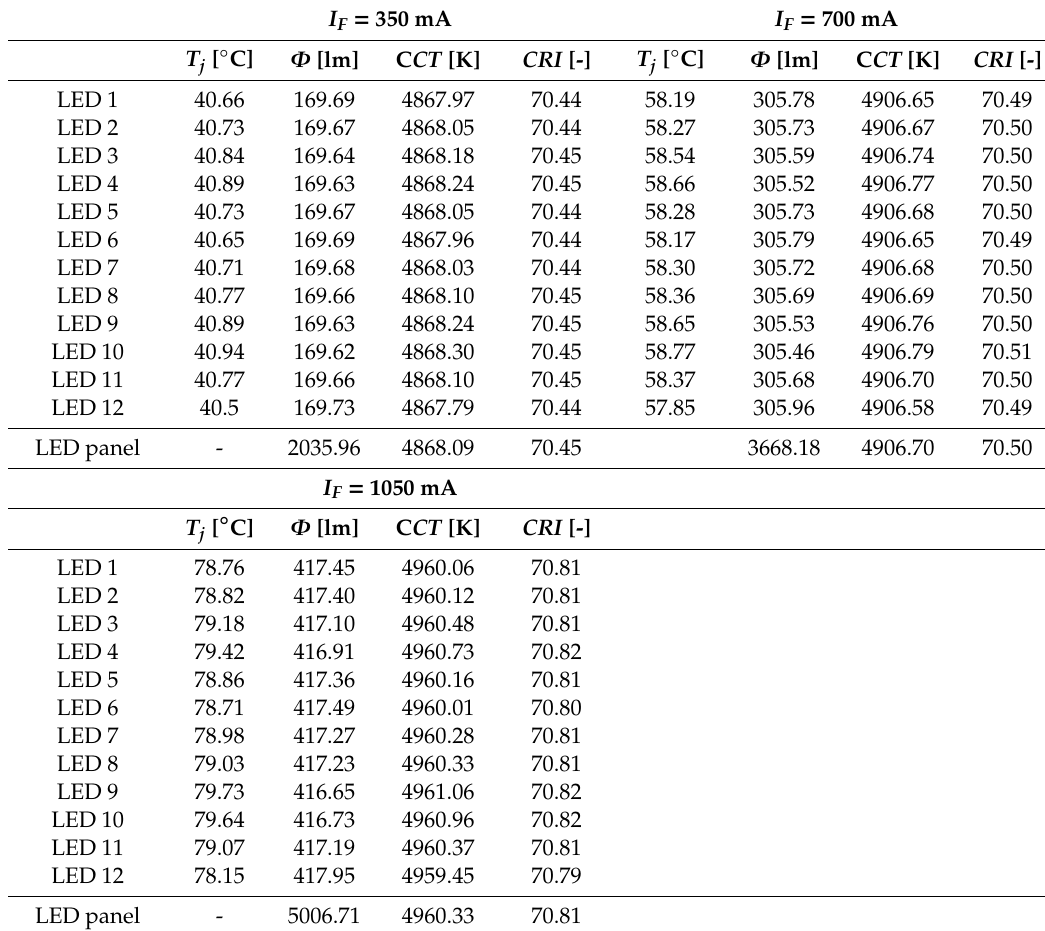
Table 4. Calculated lighting parameters for individual sources and the LED